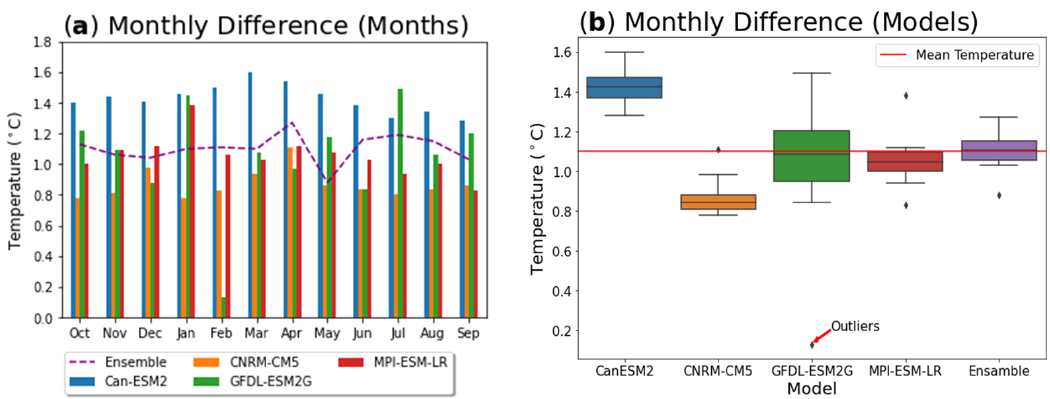
Figure 3. Basin average temperature difference (future—past): ( a ) bar plot for monthly changes; and ( b ) box-and-whisker plot for annual changes.